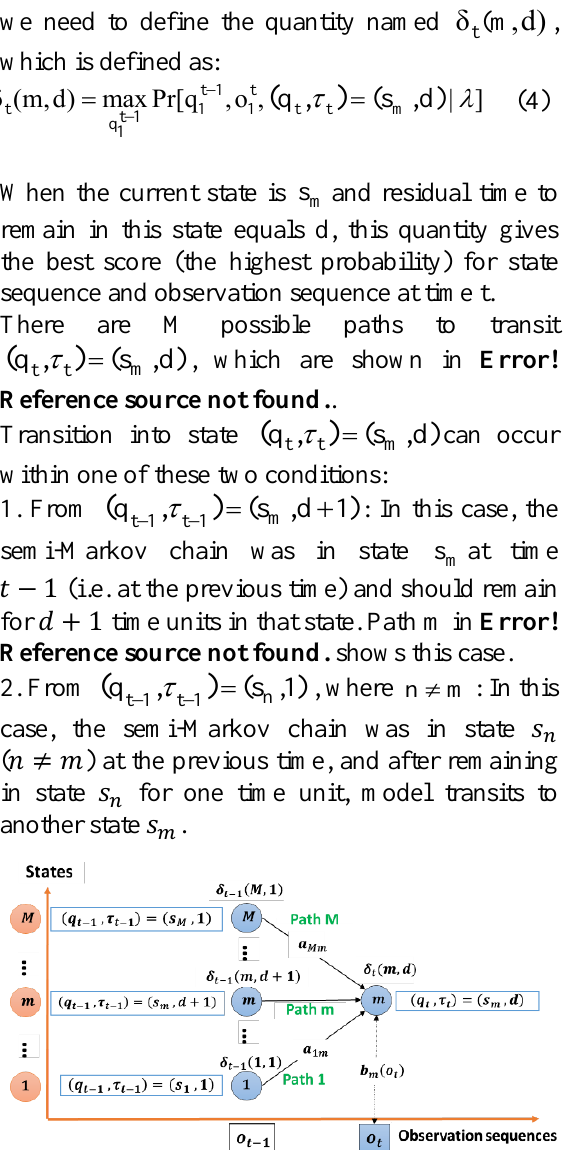
Figure 6. Illustration of performing Extended Viterbi algorithm on